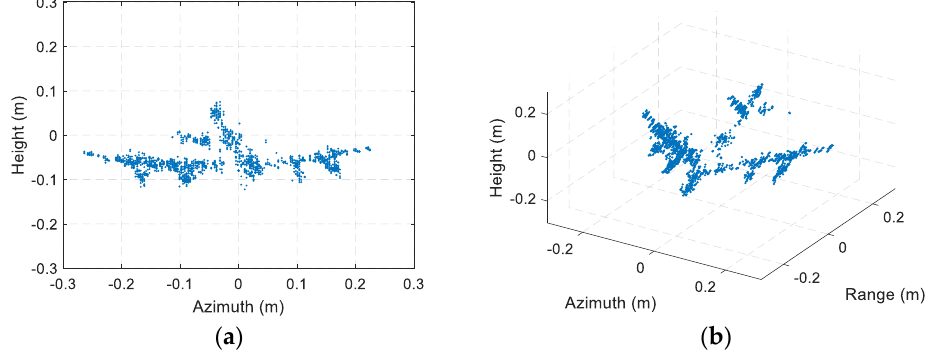
Figure 13. InISAR imaging results of A380 model with 20° rotation angle. ( a ) Front view; ( b ) Three-dimensional view.